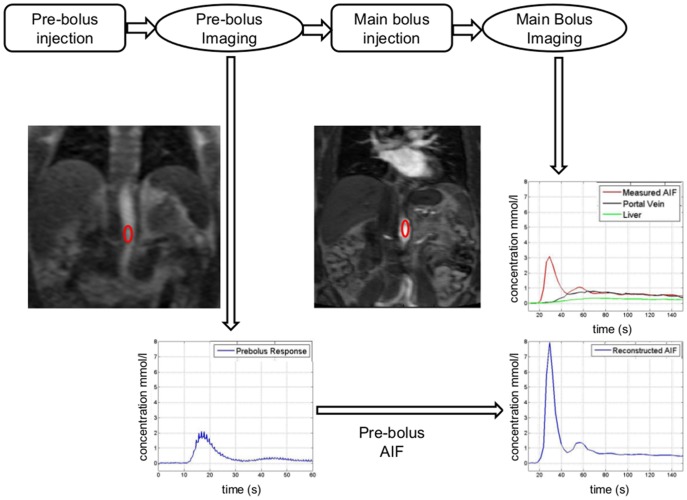
Flow diagram showing pre-bolus and main bolus AIF acquisition and processing for DCE-MRI of the liver in a 67 year-old male patient with HCV.The pre-bolus protocol consists of a high temporal resolution 2D acquisition (0.2 s). An ROI is then placed in the abdominal aorta and the concentration curve is extracted. This curve is used to reconstruct pre-bolus AIF. Main bolus imaging protocol consists of 3D acquisition with higher spatial resolution/lower temporal resolution (3.2 s). ROIs are placed on the abdominal aorta, portal vein and liver parenchyma. Pre-bolus AIF curve (bottom) demonstrates better quality compared to main bolus AIF (top).